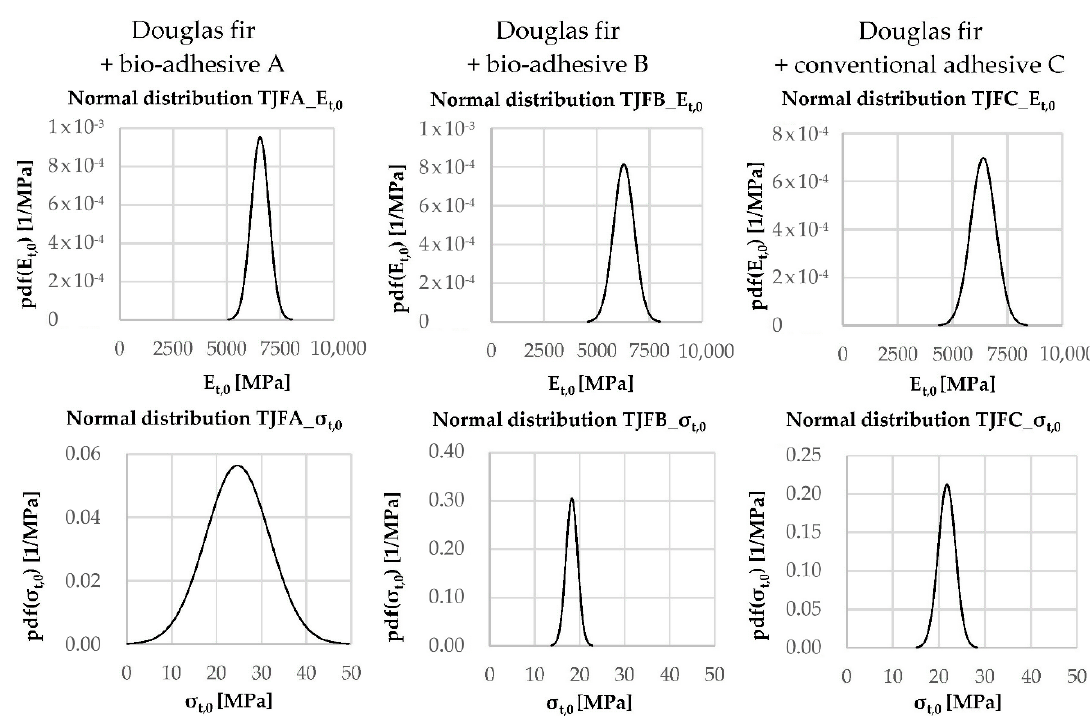
Figure A1. Statistical analysis for tensile properties on Douglas fir scarf-joint specimens.